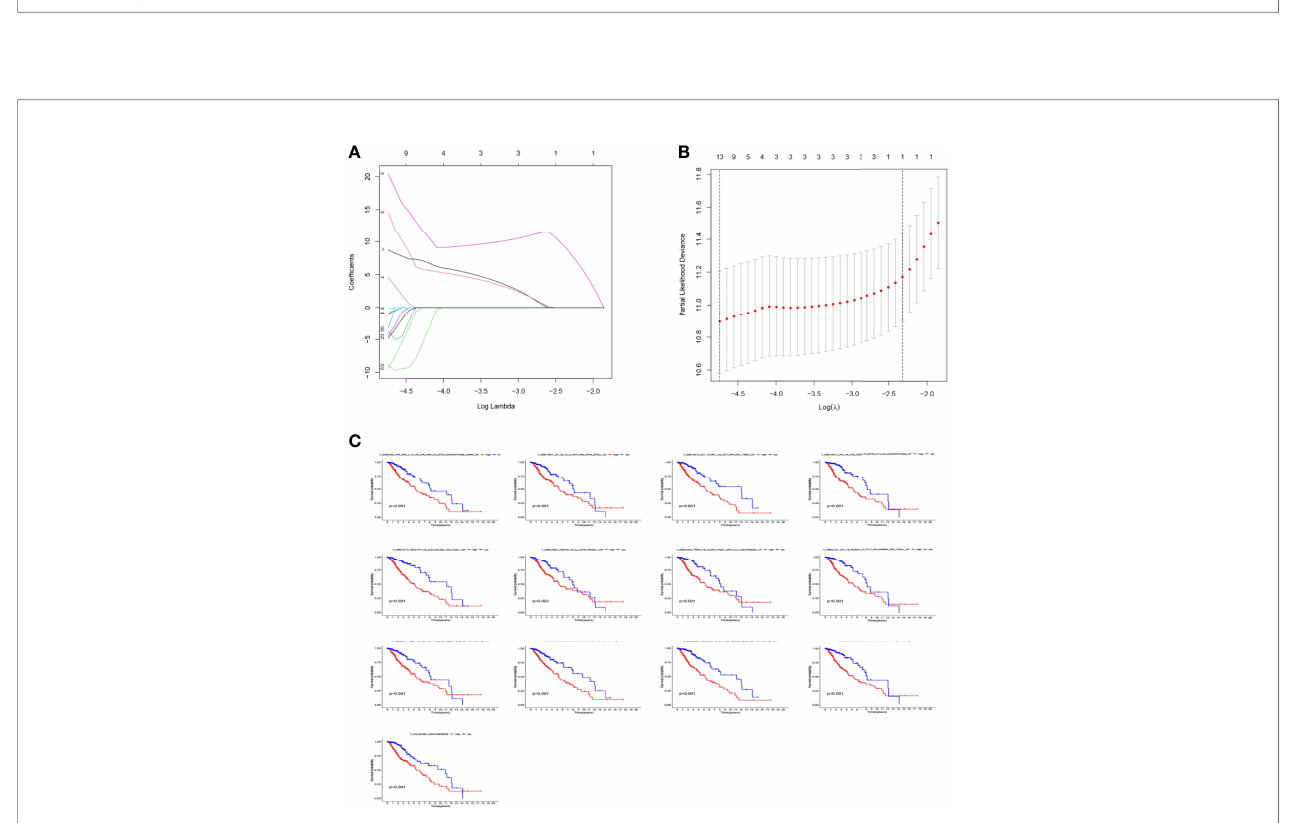
FIGURE 6 | Heat map of the relationship between the expression of gene sets affecting patient survival prognosis, and individual clinically relevant information. * means P<0.05, and *** means P<0.001.